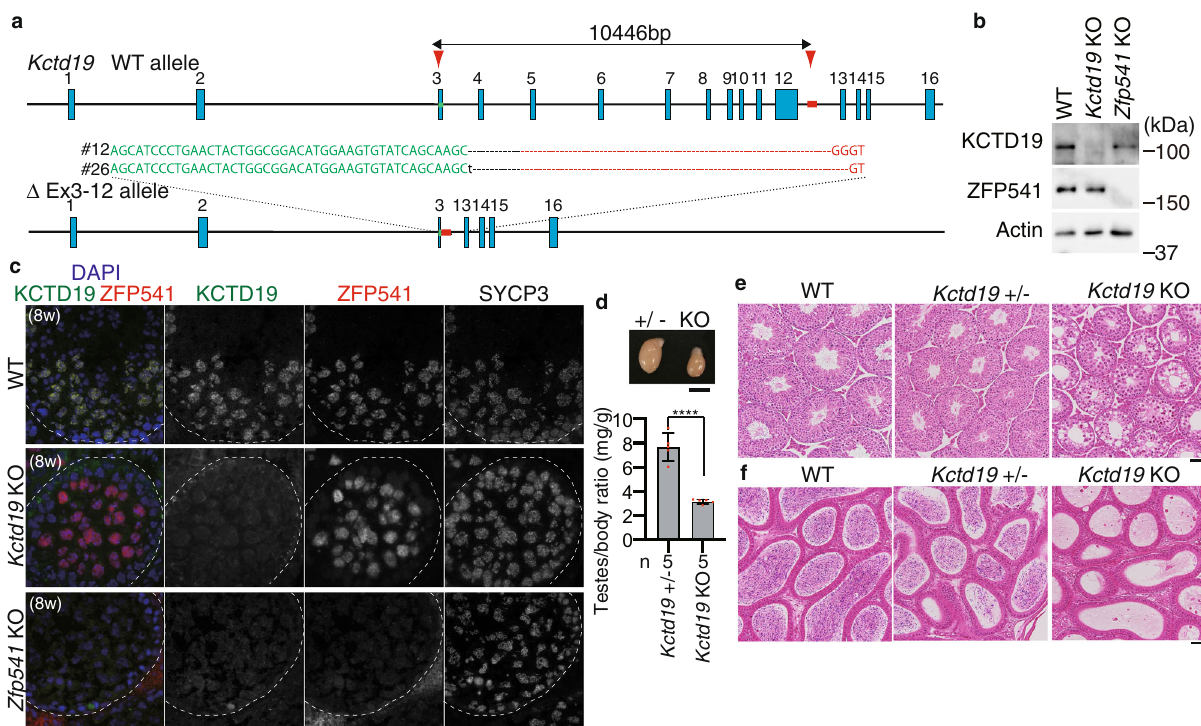
Fig. 5 Spermatogenesis was impaired in Kctd19 knockout male. a The allele with targeted deletion of Exon3-12 in the Kctd19 gene was generated by the introduction of CAS9, the synthetic gRNAs designed to target Exon 3, and the downstream of Exon12 (red arrowheads), and ssODN into C57BL/6 fertilized eggs. Two lines of KO mice were established. Line #12 of Kctd19 KO mice was used in most of the experiments, unless otherwise stated. b Immunoblot analysis of whole testis extracts prepared from mice with the indicated genotypes (P21). Biologically independent mice ( N = 2) were examined in two separate experiments. c Seminiferous tubule sections from WT, Kctd19 KO, and Zfp541 KO (8-weeks old) were immunostained as indicated. Biologically independent mice ( N = 2) were examined in two separate experiments. Scale bar: 25 μ m. d Testes from Kctd19 ± and Kctd19 KO (8-weeks old). Scale bar: 5 mm. Testis/body-weight ratio (mg/g) of Kctd19 ± and Kctd19 KO mice (8-weeks old) is shown below (mean with SD). n : number of animals examined. Statistical signi fi cance is shown by ** p = 0.0012 (two-tailed t -test). e Hematoxylin and eosin staining of the sections from WT, Kctd19 ±, and Kctd19 KO testes (8-weeks old). Biologically independent mice ( N = 3) for each genotype were examined. Scale bar: 50 μ m. f Hematoxylin and eosin staining of the sections from WT, Kctd19 ±, and Kctd19 KO epididymis (8-weeks old). Biologically independent mice ( N = 3) for each genotype were examined. Scale bar: 50 μ